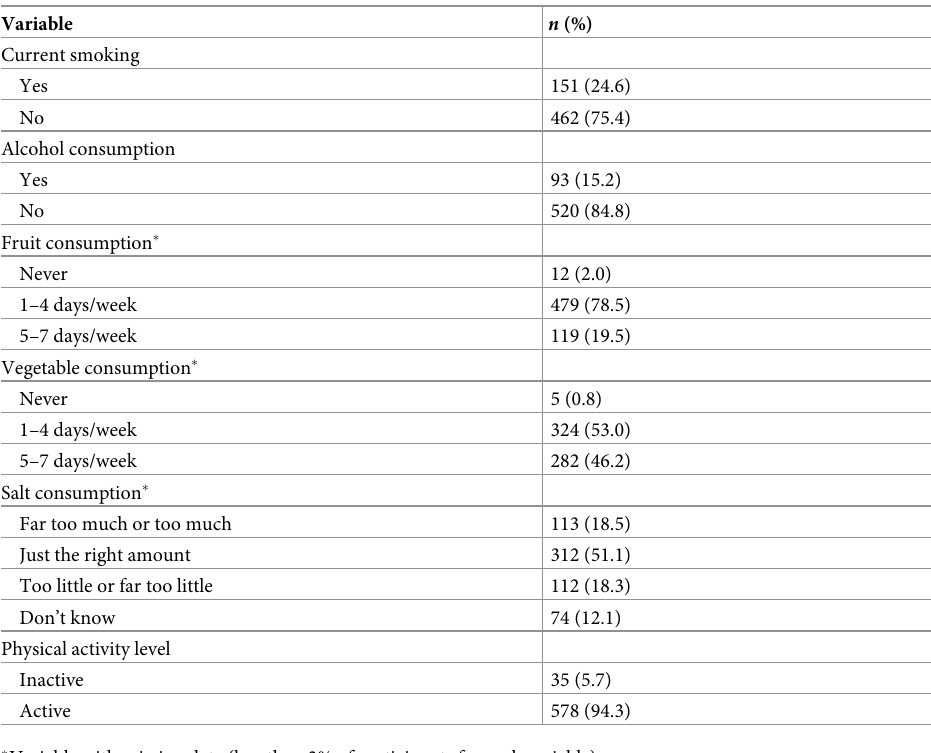
� Variable with missing data (less than 2% of participants for each